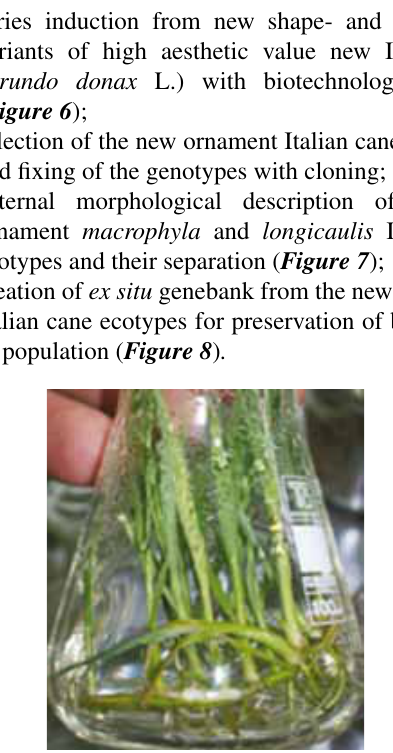
Figure 6: Series induction from new shape- and leaf colour variants of high aesthetic value new Italian cane ( Arundo donax L.) with biotechnology methods